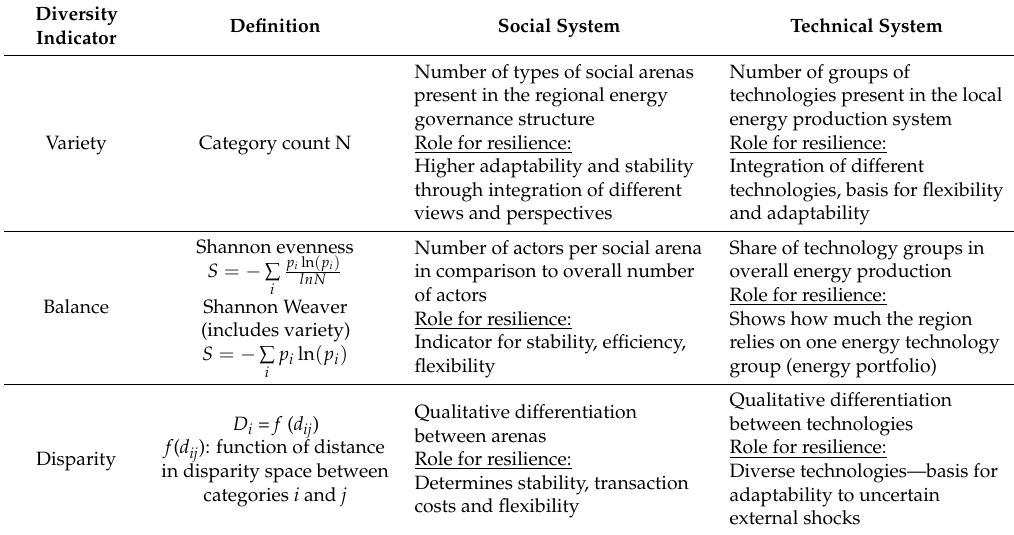
Table 1. Suggested measures for operationalizing diversity in socio-technical energy systems (based on